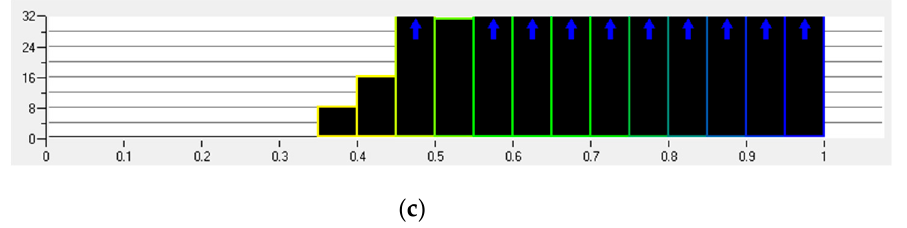
Figure 7. Numerical model of the seven-order variable-diameter pipe. ( a ) Three-dimensional model; ( b ) Grid division; ( c ) Grid quality check.